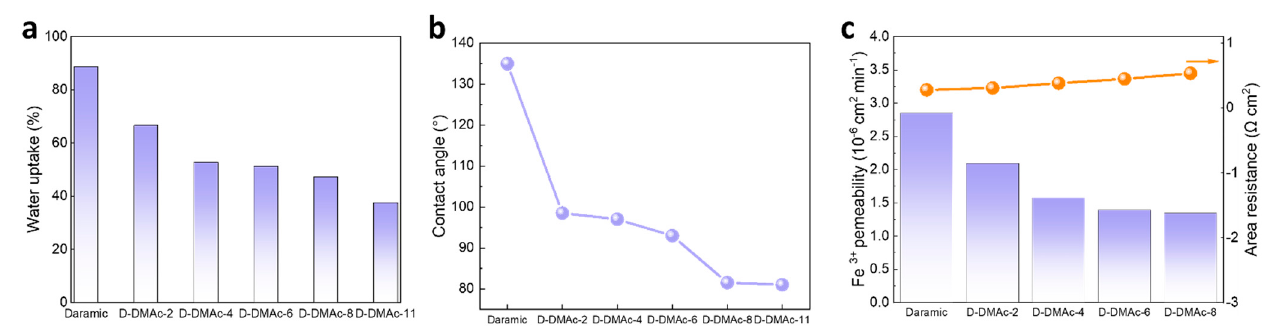
Figure 6. ( a ) Water uptake (WU); ( b ) Contact angle; and ( c ) Iron ion permeability and area resistance of D ‐ DMAc ‐ x membranes.